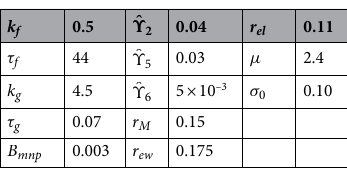
Table 3. Estimated parameters using genetic